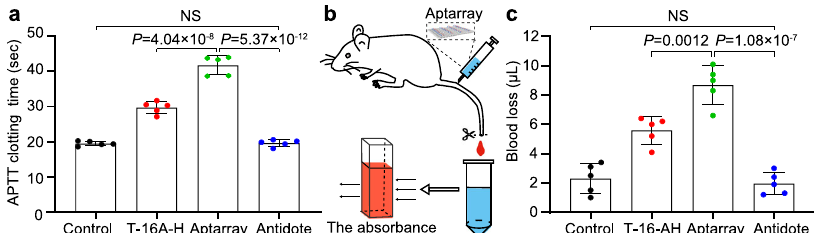
Fig. 4 Anticoagulation and the neutralization studies in mice. a Mice ( n = 5) were treated with buffer (Control), T-16A-H (20 μ M, 100 μ l) or Aptarray (~560nM, 100 μ l) via a single tail vein injection. Antidotes were administrated intravenously to mice followed by Aptarray for the neutralization study in vivo. Plasma was collected from treated mice and APTT was measured. b Schematic drawing of a murine tail-transection bleeding model. c Mice ( n = 5) were treated with buffer (Control), T-16A-H (20 μ M, 100 μ l) or Aptarray (~560 nM, 100 μ l). Antidotes were then administrated intravenously to the anticoagulated animals for neutralization. The tail tips were amputated and the blood loss of mice was measured. Data represent the mean ± s.d. from fi ve ( a , c ) independent replicates. Statistical signi fi cance ( a , c ) was calculated by one-way ANOVA with the Tukey post hoc test. NS, P > 0.05. Source data are provided as a Source Data fi